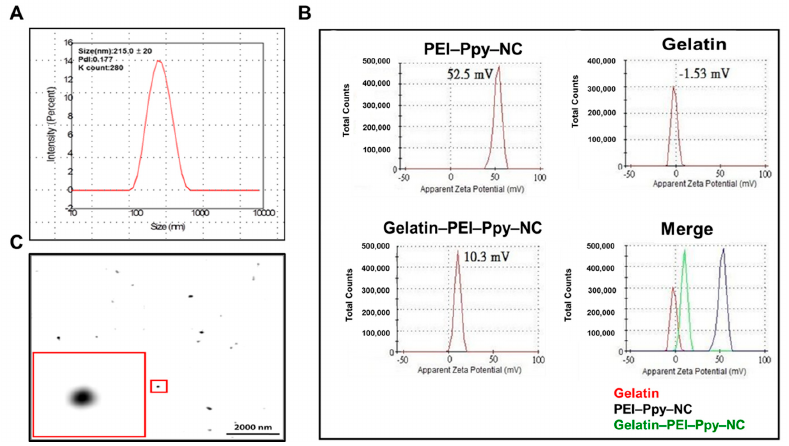
Figure 2. ( A ) Dynamic light scattering (DLS) size analysis of PEI–Ppy-NC; ( B ) zeta potentials of the test samples PEI-Ppy-NC, gelatin, and gelatin-PEI–Ppy-NC; ( C ) TEM image of PEI-Ppy-NC with magnified